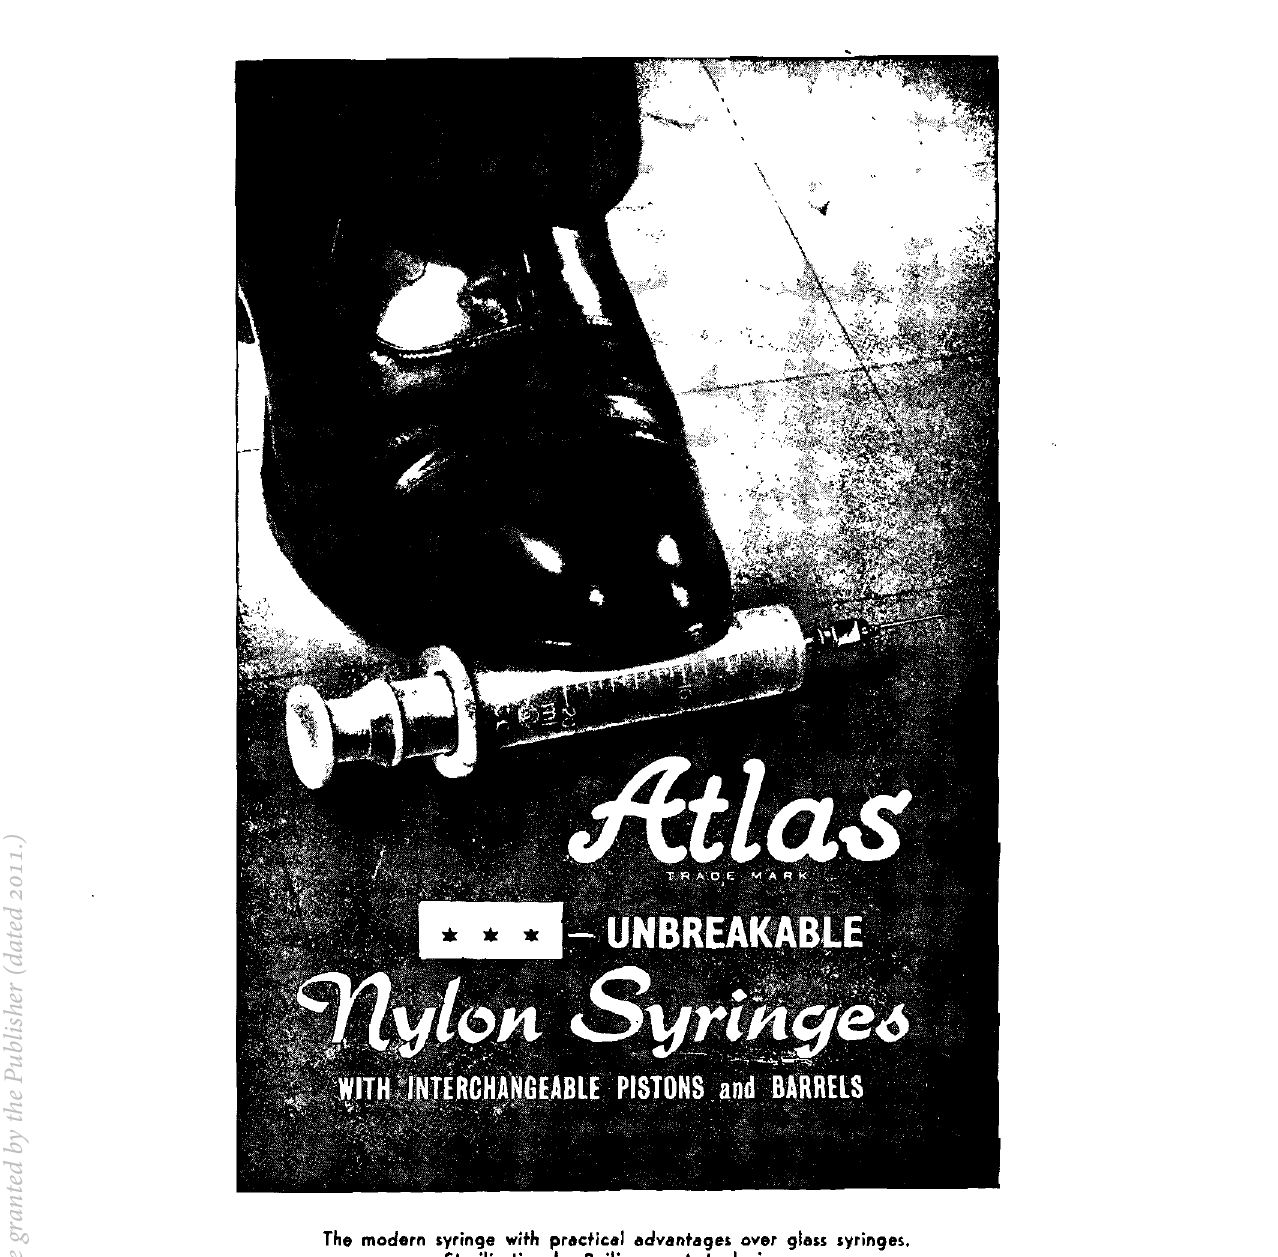
The modern syringe with practical advantages over glass syringes. Sterilisation by Boiling or Autoelaving. Obtainable in All Nylon. Veterinary (record metal tip) and Luer lod. All syringes interchangeable with each other